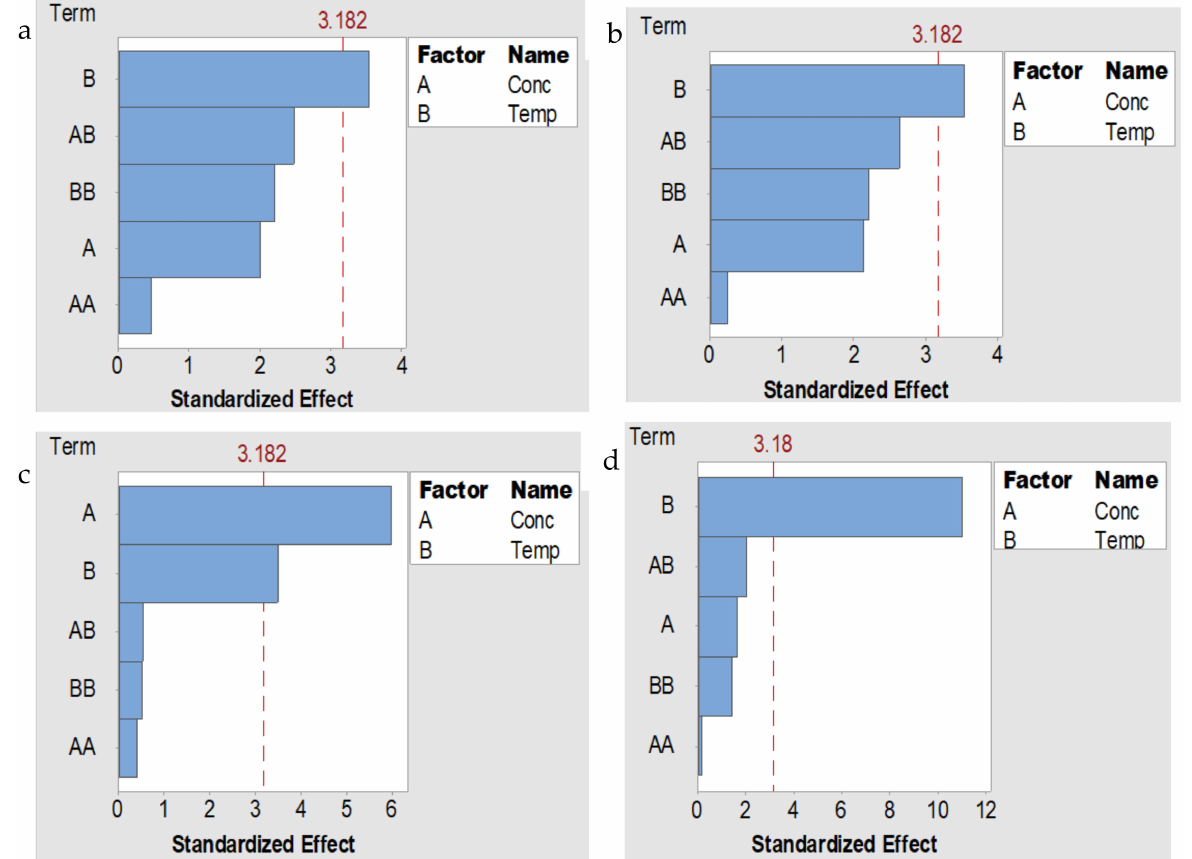
Figure 4. Pareto chart of standardized effects of concentration and temperature on solvation of silk fibroin in ( a ) LiCl, ( b ) CaCl 2 , ( c ) LiBr, and ( d ) Ca(NO 3 ) 2 -FA solvent